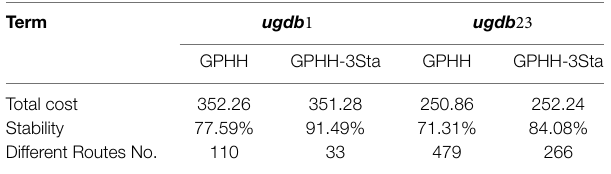
TABLE 6 | The comparable results between GPHH and GPHH-3Sta on ugdb 1 and ugdb 23 ,